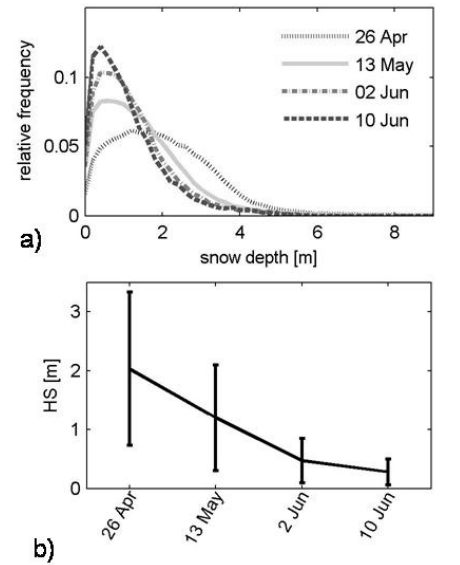
Fig. 5. (a) Histograms and statistics (b) of snow depth (HS) at the time of each scan. Only cells which were snow covered at the time of each scan are included to (a). Intervalsize 63. Statistics in (b) refer to the scanned area. The black line indicates the mean values and the error-bars the standard deviations.